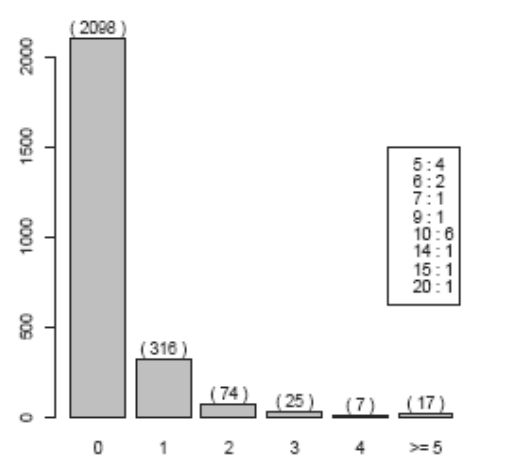
Figure 1 – Frequency distribution of the number of hospital admissions for RSA (Randomly Se- lected Adult), in the box the frequencies of number of hospitalizations of RSA with 5 or more hos- pitalizations (in addition, 82 missing observations are